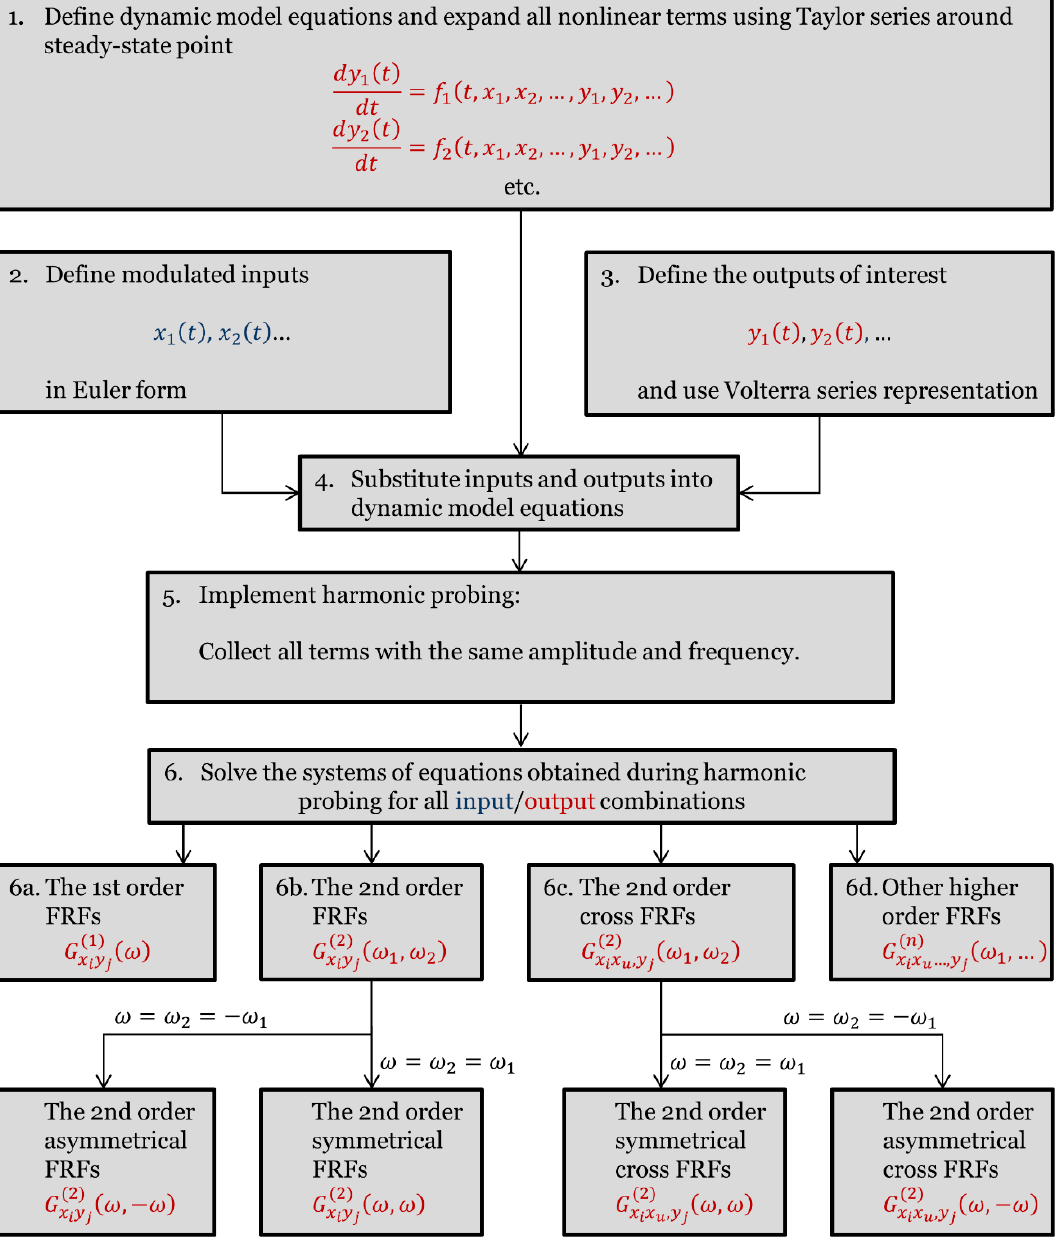
Figure 2. Procedure for derivation of the theoretical FRFs.